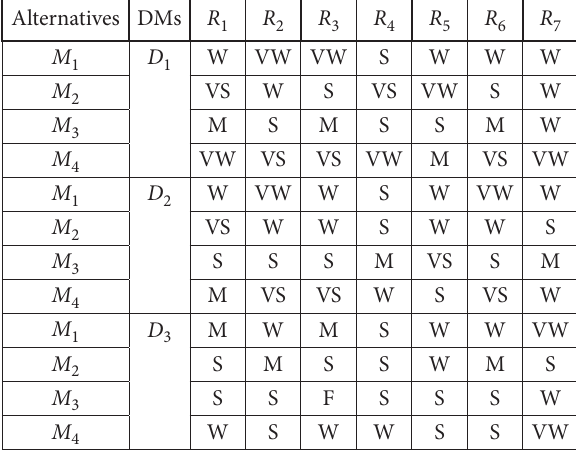
Table 3. Rating of alternatives with regard to criteria evaluated by DMs